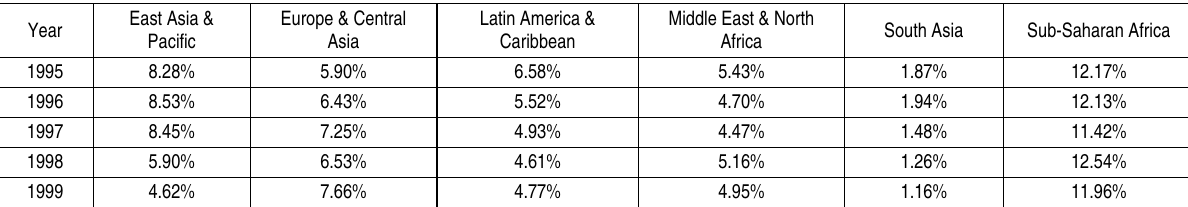
Table 8. Trends in ST external debt to GDP